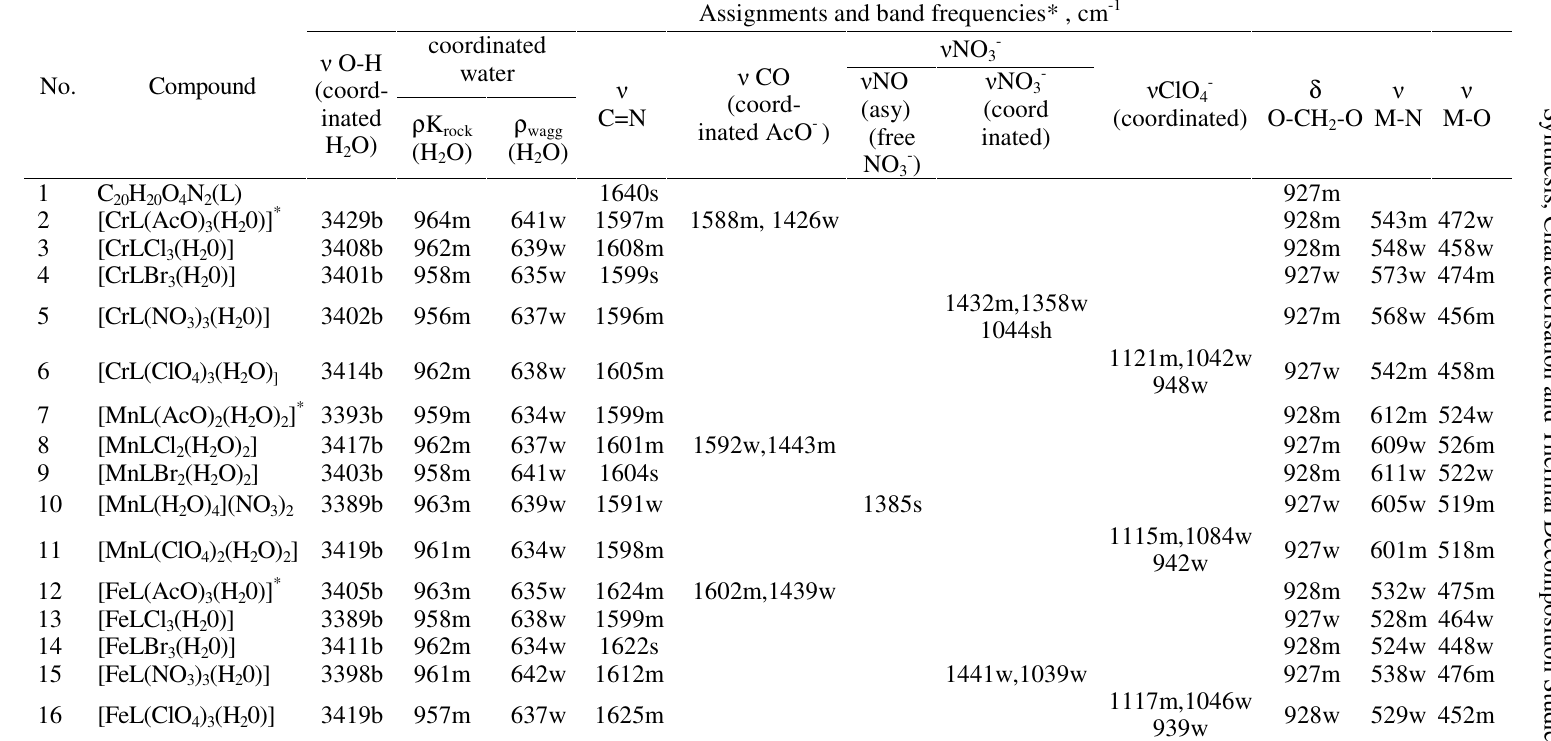
Table 2 . Significant IR spectral bands of ligand and Cr(III), Mn(II) and Fe(III) complexes.